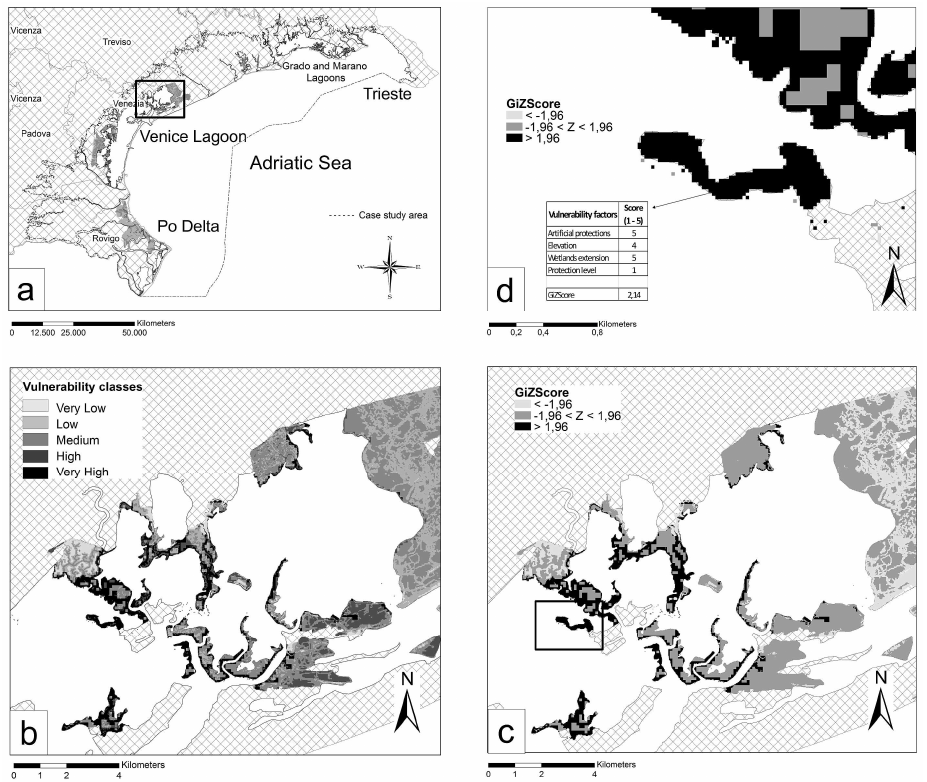
Fig. 3. Vulnerability map for the wetland receptor to the sea level rise inundation impact on the North Adriatic coast (a) and in the north- ern Venetian Lagoon (b) . Maps representing the hot spots analyzed in the northern Venetian Lagoon (c) and a detailed hot spot with its contributing vulnerability scores (d)